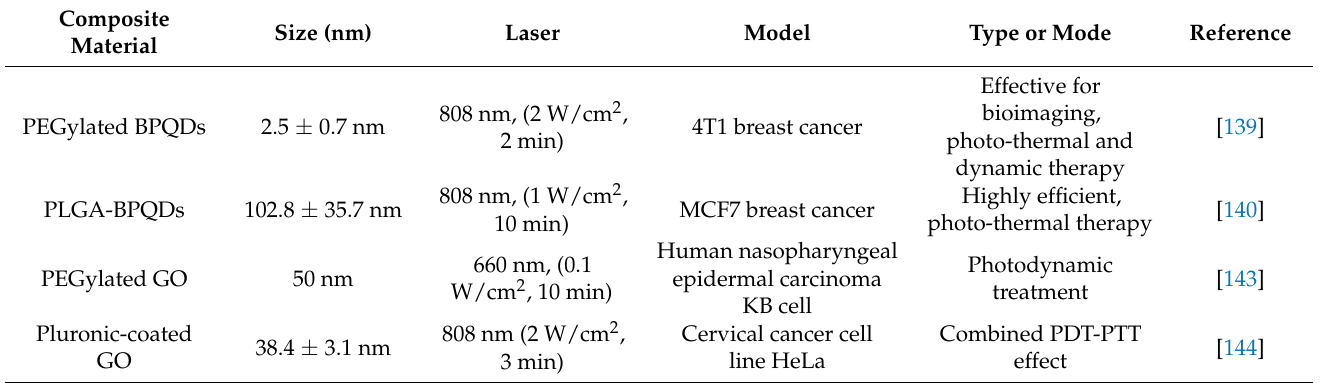
Table 5. A comparative photo-thermal/dynamic therapeutic properties of composites of BP polymers and graphene